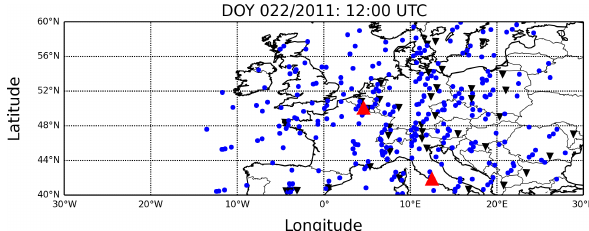
Figure 4. Example of the NeQuick modeled electron densities (left) and the reconstructed electron densities (right) on DOY 22 (2011) at 12:00UTC over 40–60 ◦ N and 30 ◦ W–30 ◦ E. The heights 200– 350km within the selected European region are